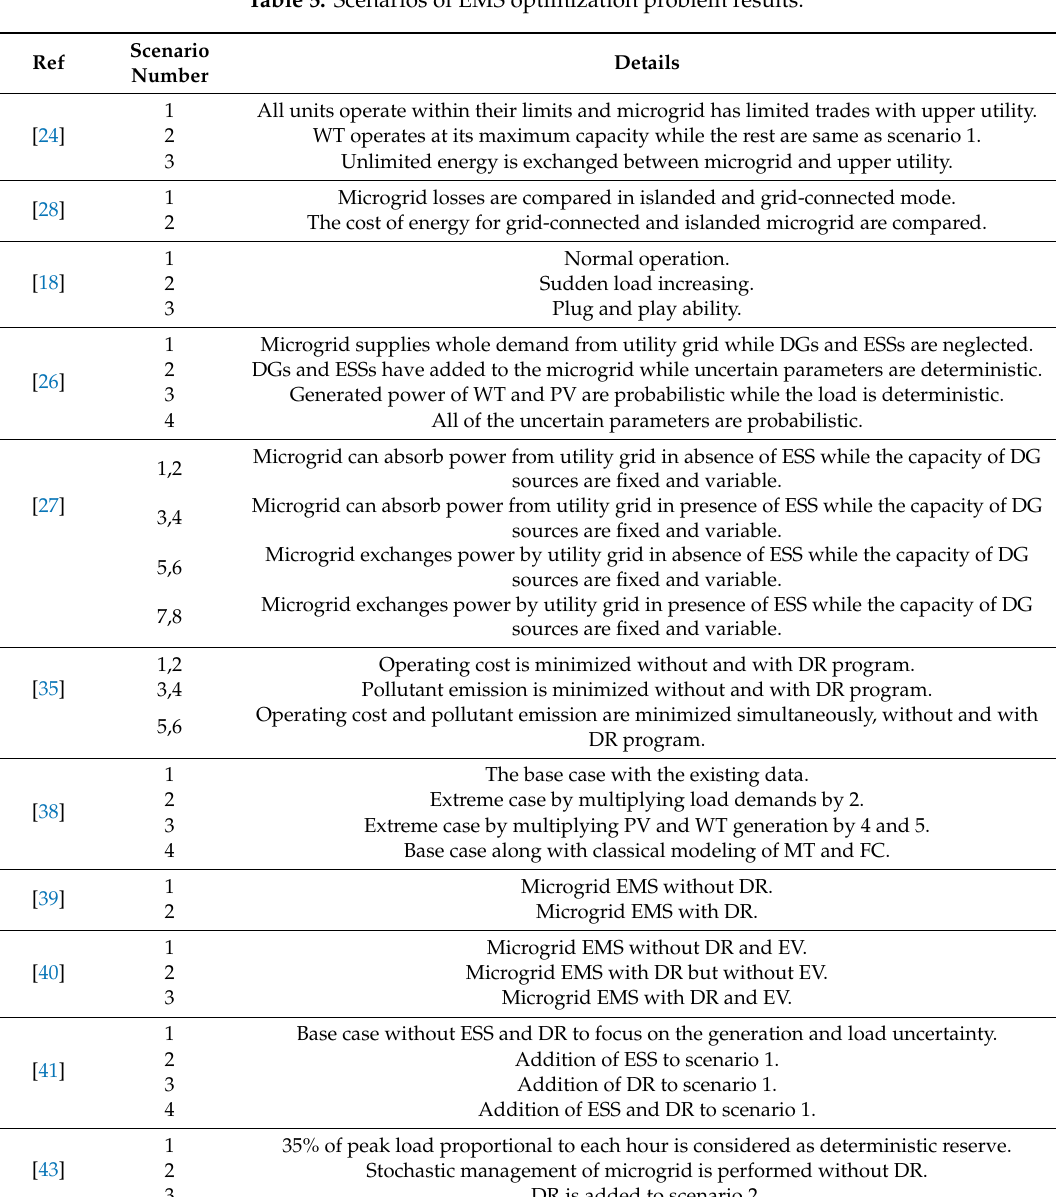
Table 5. Scenarios of EMS optimization problem